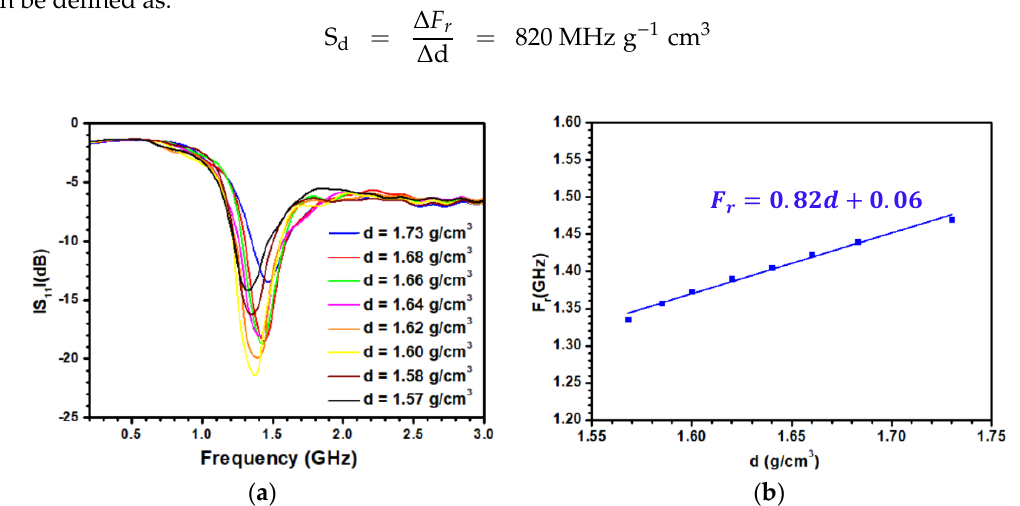
Figure 8. ( a ) Variation of the S 11 parameter as a function of the frequency for different densities of the sediments for the antenna working at 1.3 GHz; ( b ) variation of the resonant frequency as a function of the density.